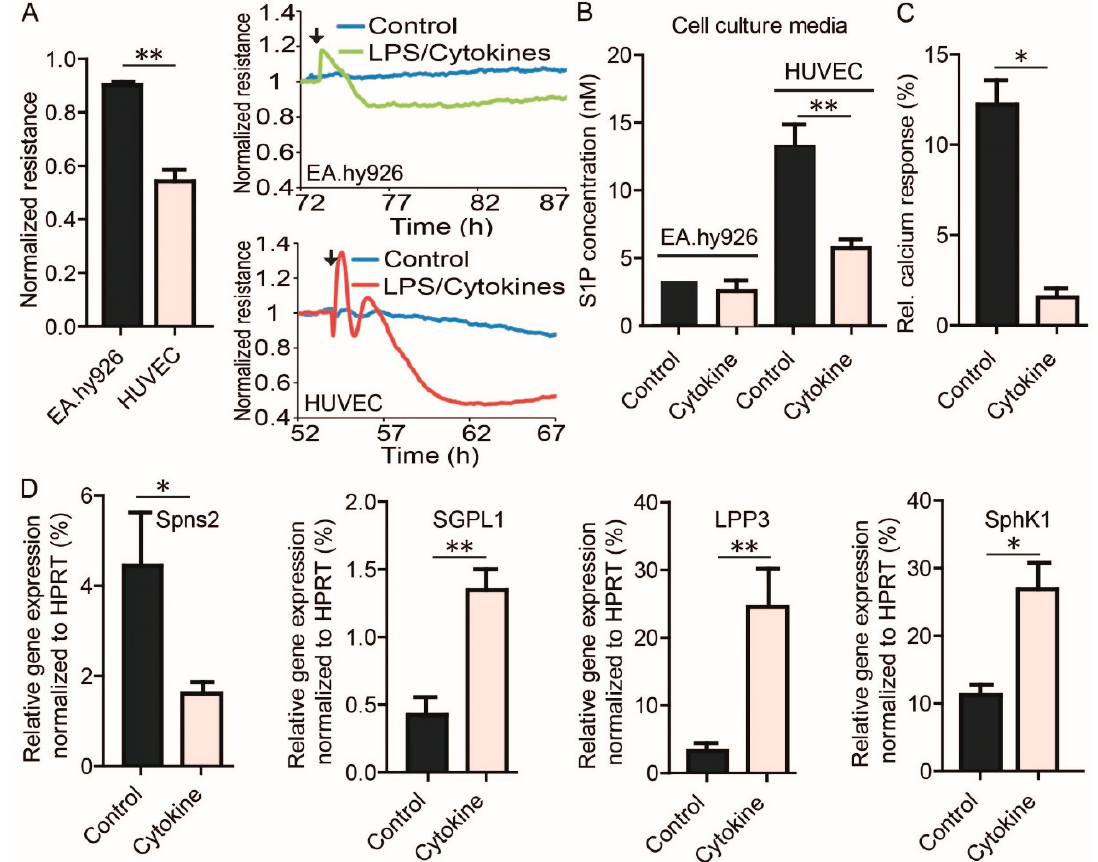
Figure 5. Influence of LPS and cytokines on EC barrier stabilization. ( A ) Resistance following treatment with a mix of LPS and cytokines (50 ng / mL IL1 β , 50 ng / mL TNF α , 1 µ g / mL LPS). Normalized resistance values are resistance of cells 12 h after LPS / cytokine treatment divided by resistance of carrier-treated control cells at the same time and are means ± SEM, n = 3, ** p < 0.01, determined by a two-sided Student’s t -test. Line plots represent one experiment out of three with black arrows indicating the addition of LPS and cytokines or vehicle at the corresponding time. ( B ) LC-MS / MS quantification of extracellular S1P production by EA.hy926 and HUVEC after stimulation with LPS and cytokines or vehicle control. ( C ) Intracellular calcium response in rat hepatoma HTC4 cells transfected with human S1PR1 and the human G α i subunit of trimeric G proteins, stimulated with lipid extracts from HUVEC without or with LPS and cytokines as indicated. ( D ) qPCR analysis of Spns2 , SGPL1 , LPP3 , and SphK1 expression in cytokine mix treated HUVEC. ( B – D ) Data are means ± SEM, n = 3, * p < 0.05, ** p < 0.01, determined by two-sided Student’s t